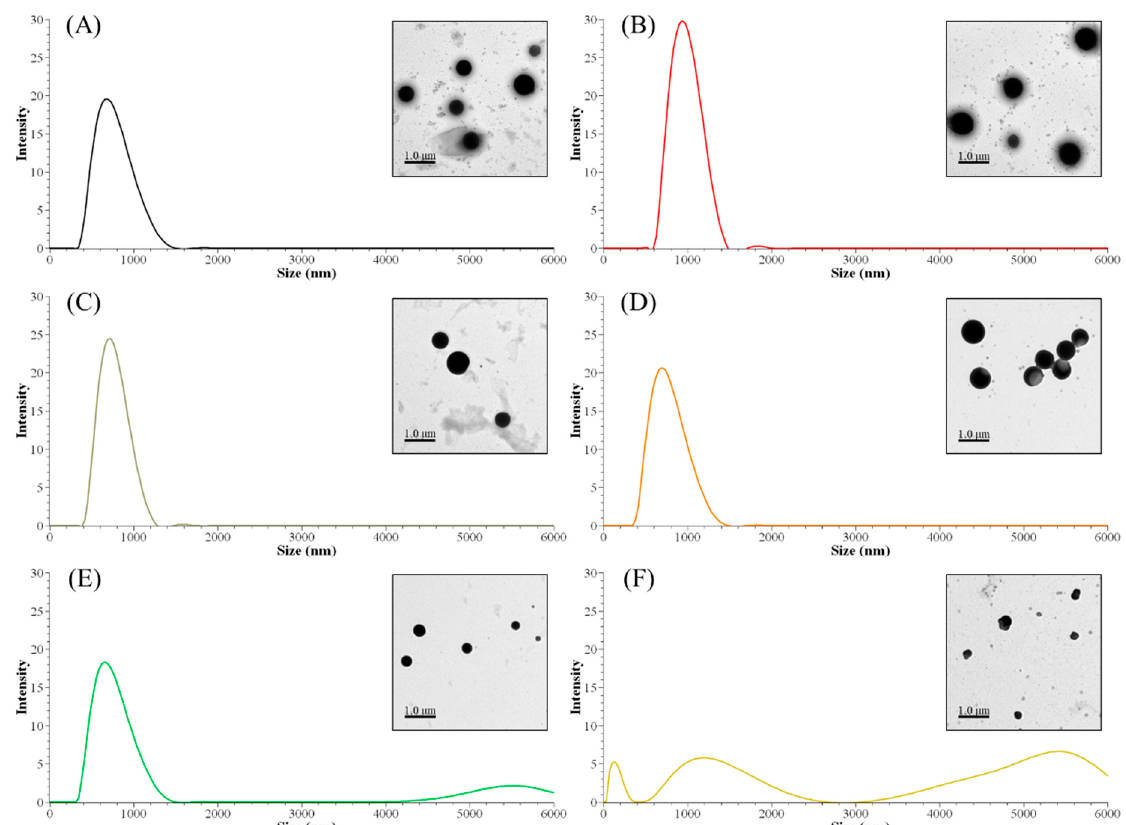
Figure 2. Peak size distributions of FALNPs and their representative TEM images. ( A ) ALNP-C4, ( B ) FALNP1, ( C ) FALNP2, ( D ) FALNP3, ( E ) FALNP4, and ( F ) FALNP5.